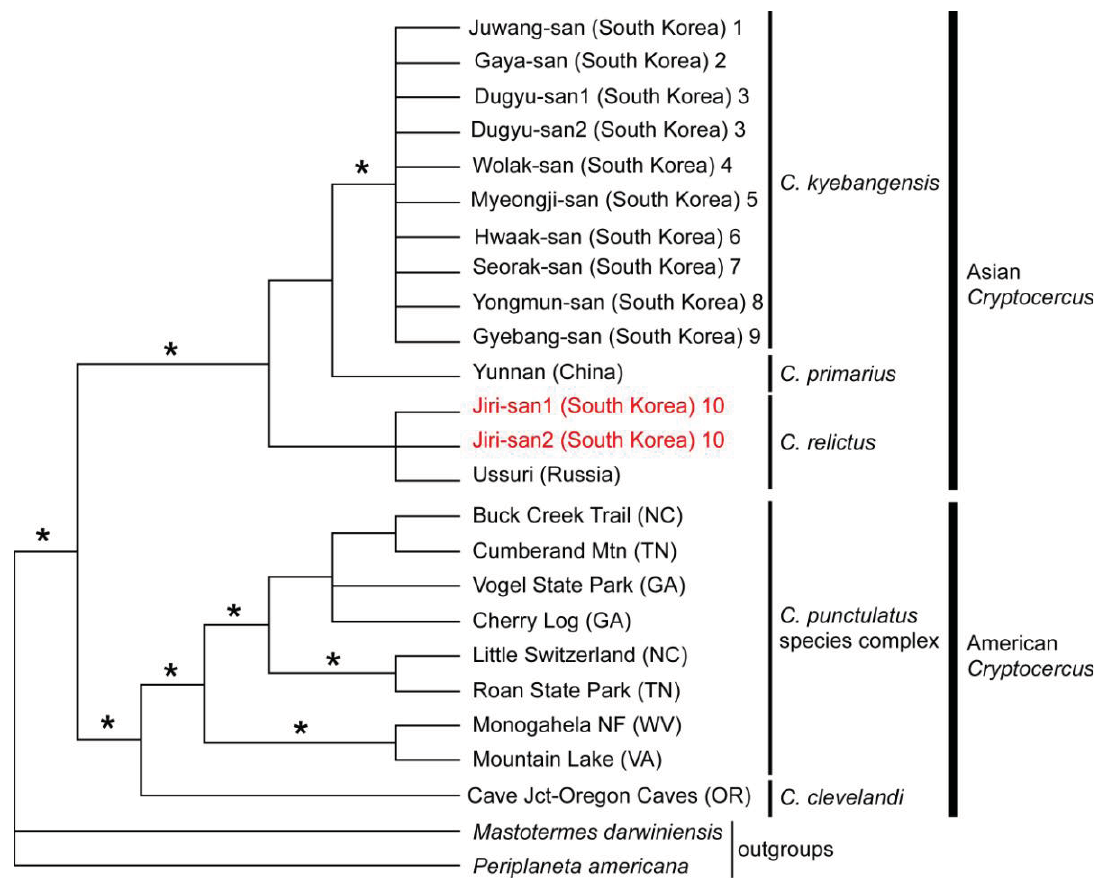
Figure 3. Phylogenetic relationships among endosymbionts of Cryptocercus spp. inferred from 16S rRNA gene sequences (re-drawn from the figure shown in Maekawa et al. [13]). Nodes with strong support (more than 90% Bayesian posterior probabilities and MP bootstrap probabilities) are indicated by an asterisk. Each terminal is labeled with the collection location name and species name. Collection location numbers are also indicated for the South Korean samples (shown in